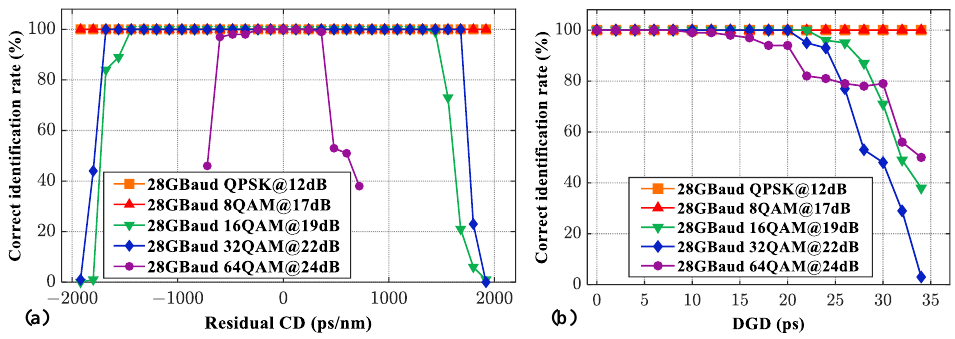
Figure 12. The tolerance with respect to ( a ) residual CD and ( b ) DGD of the proposed scheme.